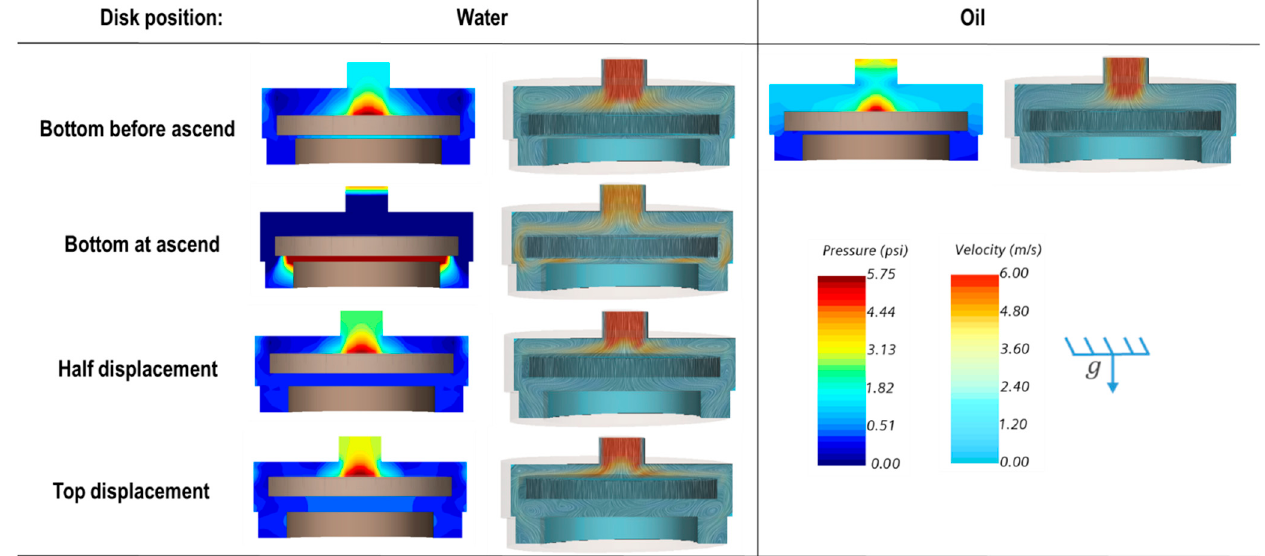
Figure 5. Hydrodynamic profile of the RCP valve described with velocity and pressure contours. At “the bottom before ascend,” the velocity profiles for oil and water differ signifi- cantly. Water exhibits velocity magnitudes approximately four times higher than oil at the top of the disk because of the inlet stream (red color contours). Additionally, two vortices are formed at the top edges of the disk. In contrast, the streamlines of oil indicate a more uniform flow pattern. These differences are attributed to the fluids’ viscosity contrasts.